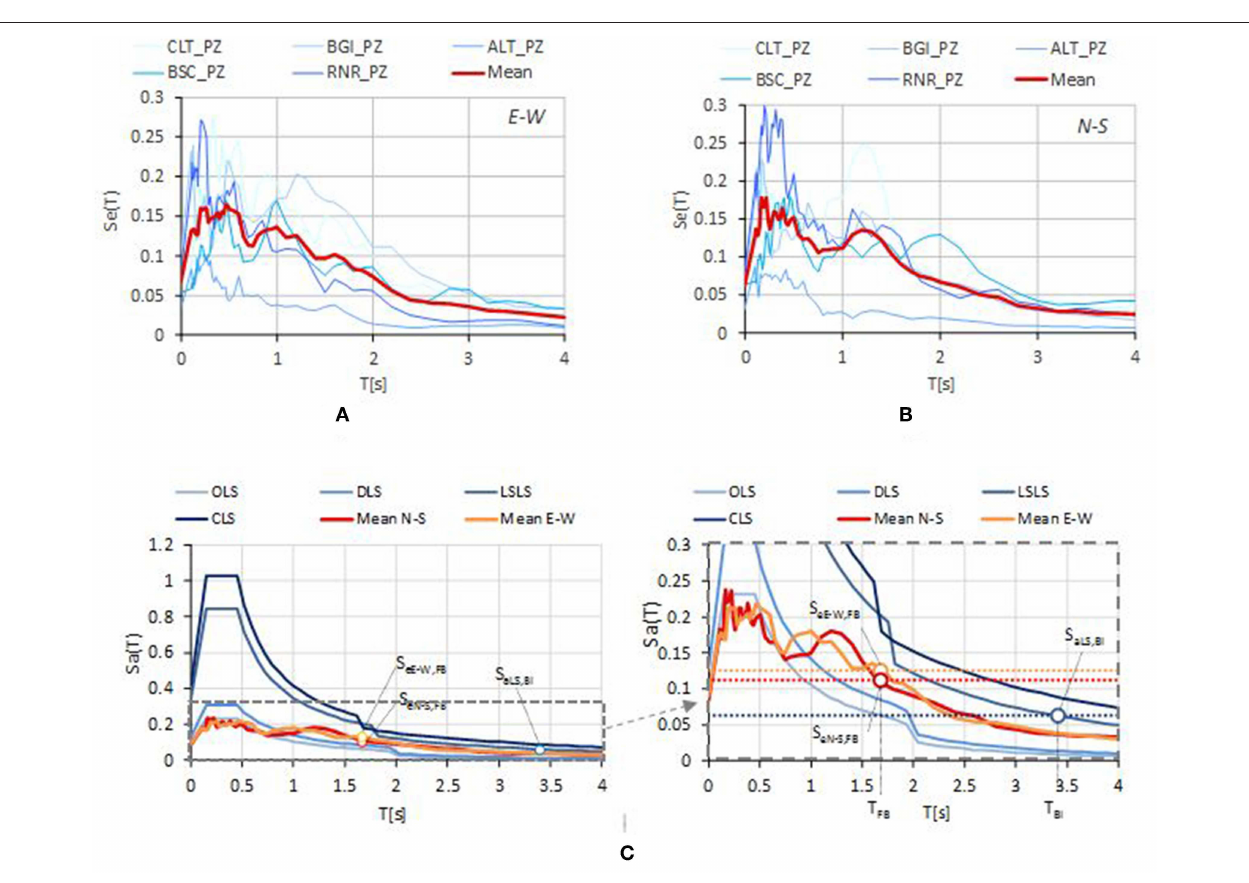
FIGURE 14 | Expected demand of Irpinia earthquake for the site of Potenza. (A) Recorded GMs spectra scaled for the site of Potenza in the E-W direction, (B) Recorded GMs spectra scaled for the site of Potenza in the N-S direction, (C) Mean spectra of GMs and code spectra for a soil type